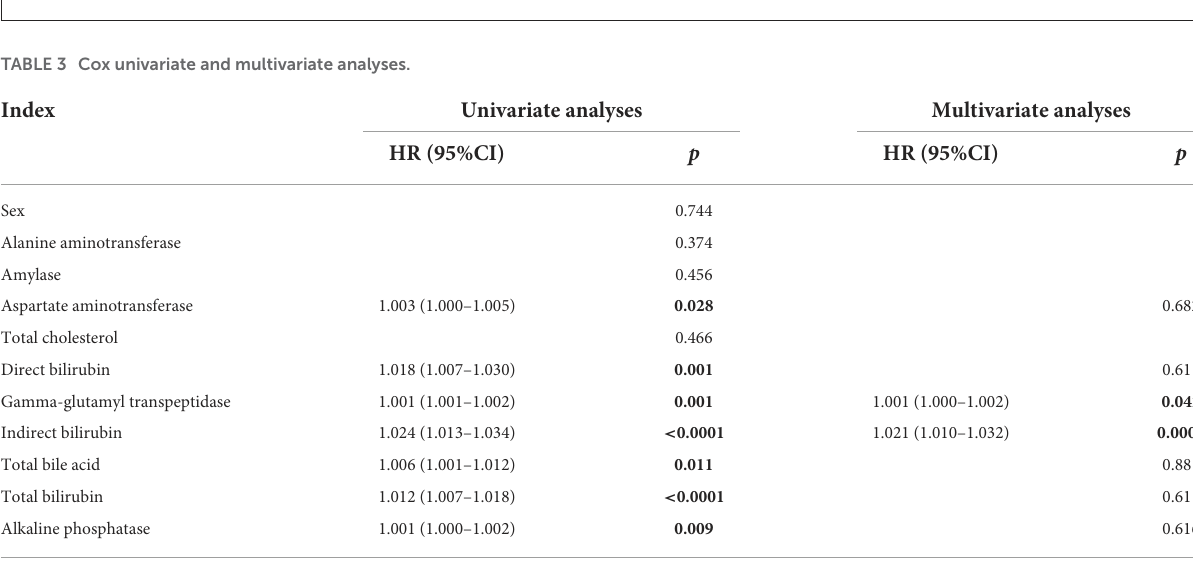
FIGURE2 Patients were divided into “high” and “low” groups according to the optimal cut-offs which were determined by Youden index. Kaplan–Meier analyses of preoperative perforation-free survival for (A) serum GGT level, and (B) serum IDB level were analyzed. Among them, five patients lost data of GGT levels and four lost data of IDB levels. Log-rank test was used.